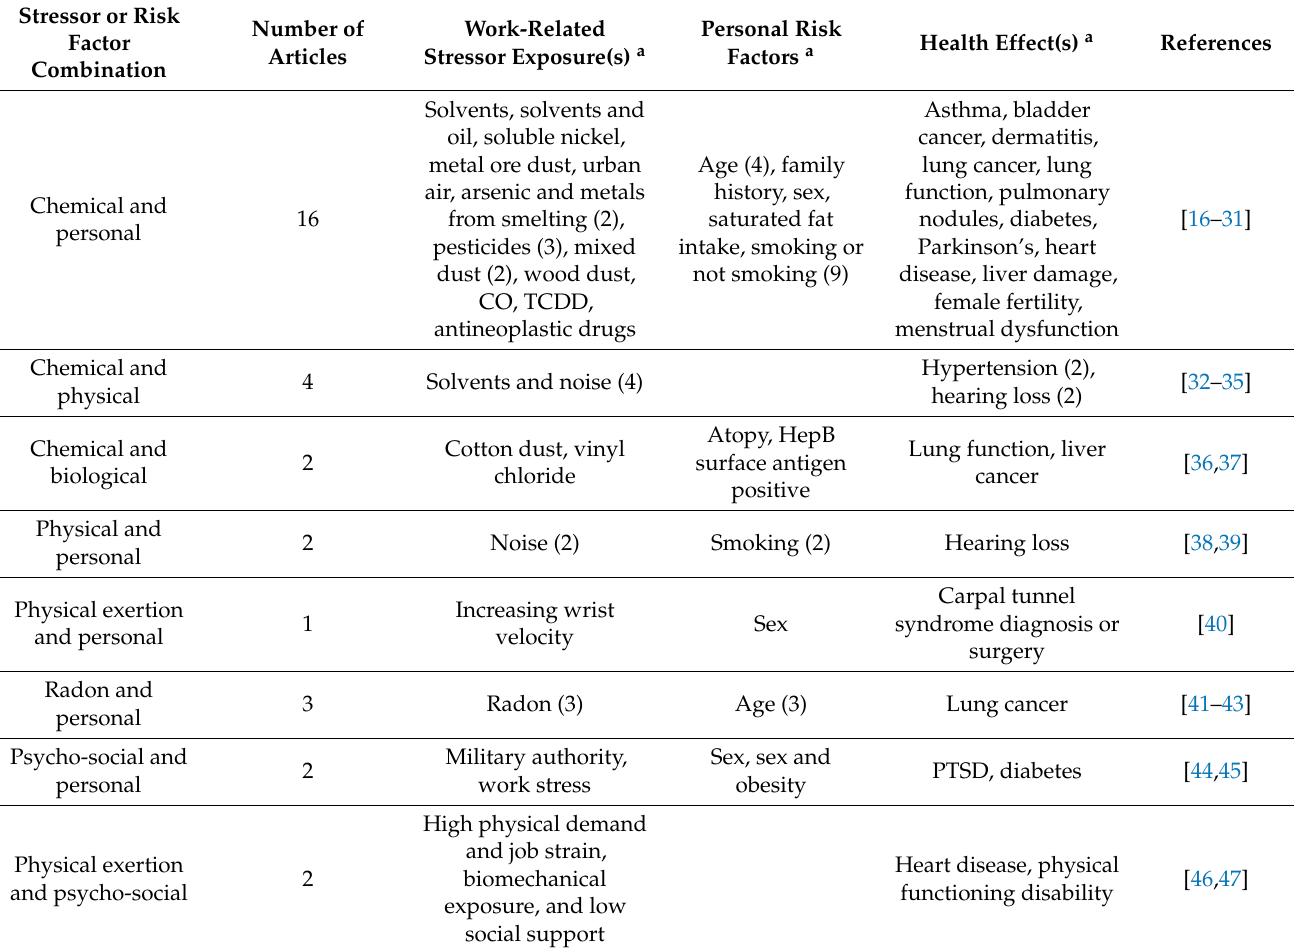
Table 1. Summary of included